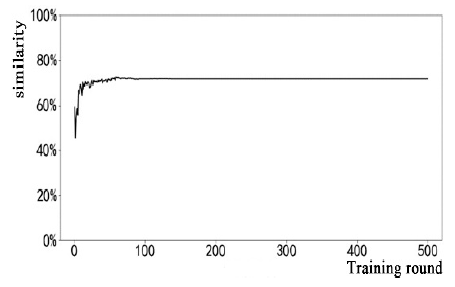
Figure 20. Expert-driven learning with a factor of 2/3.